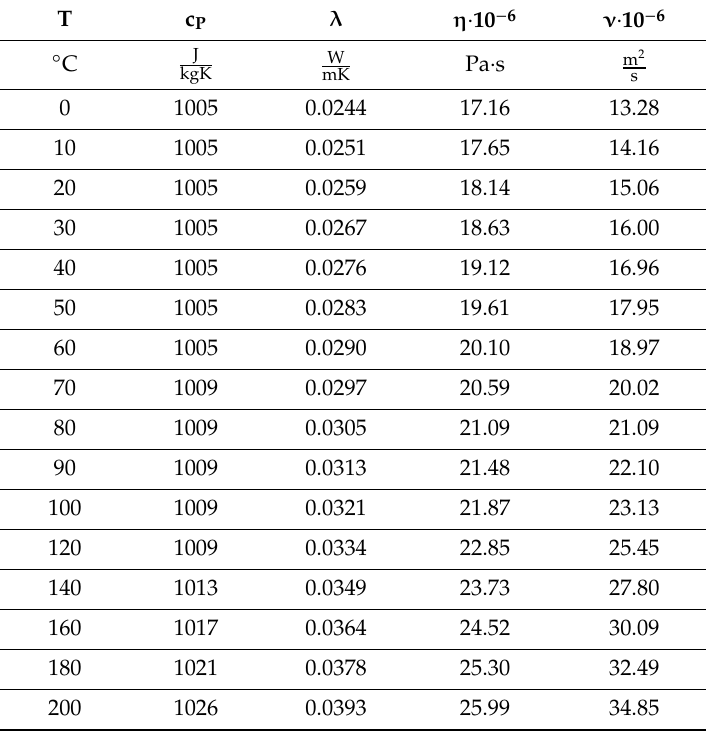
Table 2. Thermal properties of air at 1 atm